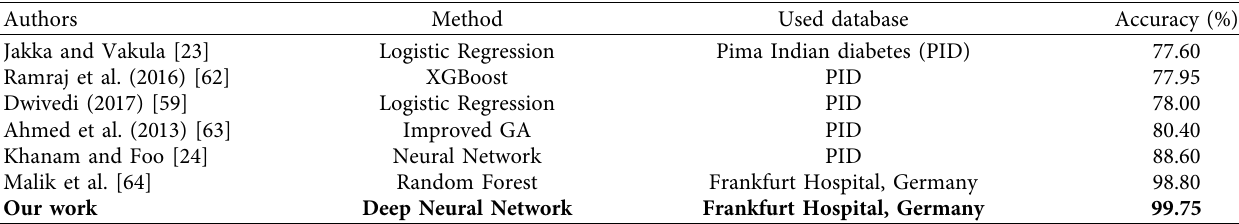
Table 6: Comparison of the proposed system with state-of-the-art methods in terms of accuracy.